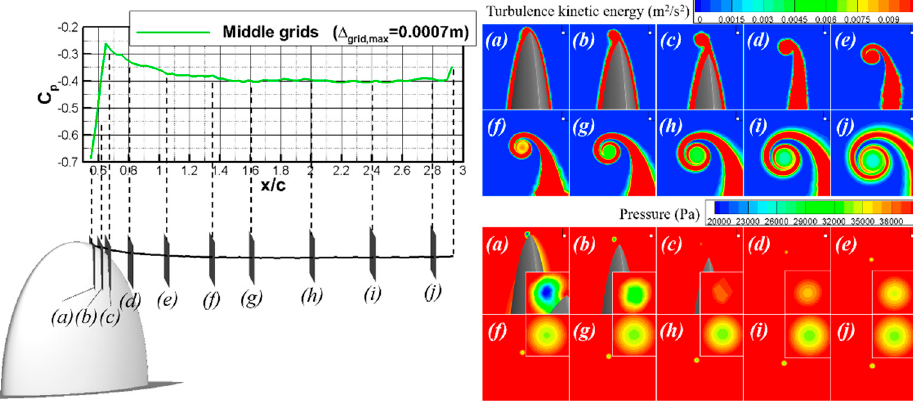
Figure 17. Variation of pressure and turbulent kinetic energy along vortex core line in a Reynolds- averaged Navier–Stokes (RANS) flow field using Reynolds Stress turbulence model.